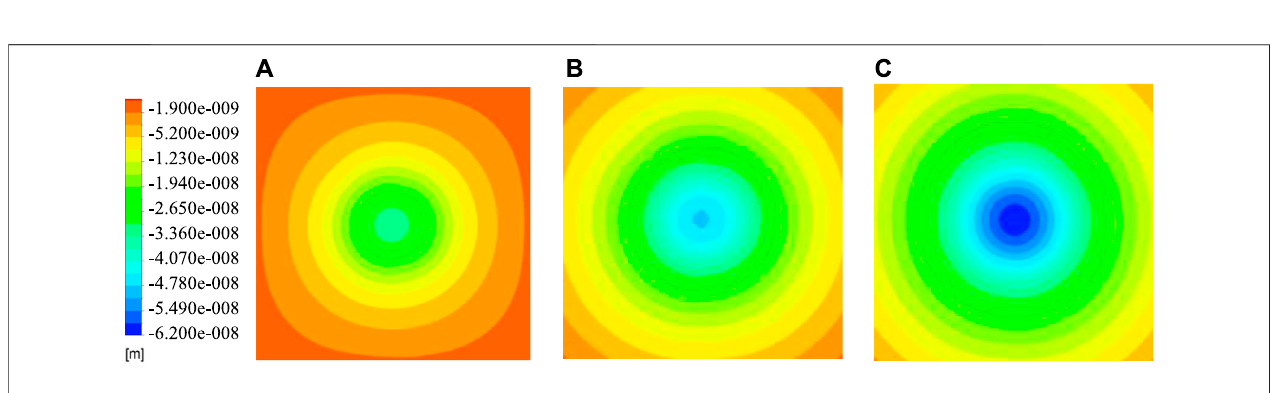
FIGURE 8 | Deformation diagram of the substrate at different irradiation times: (A) 10, (B) 30, and (C) 60 s.